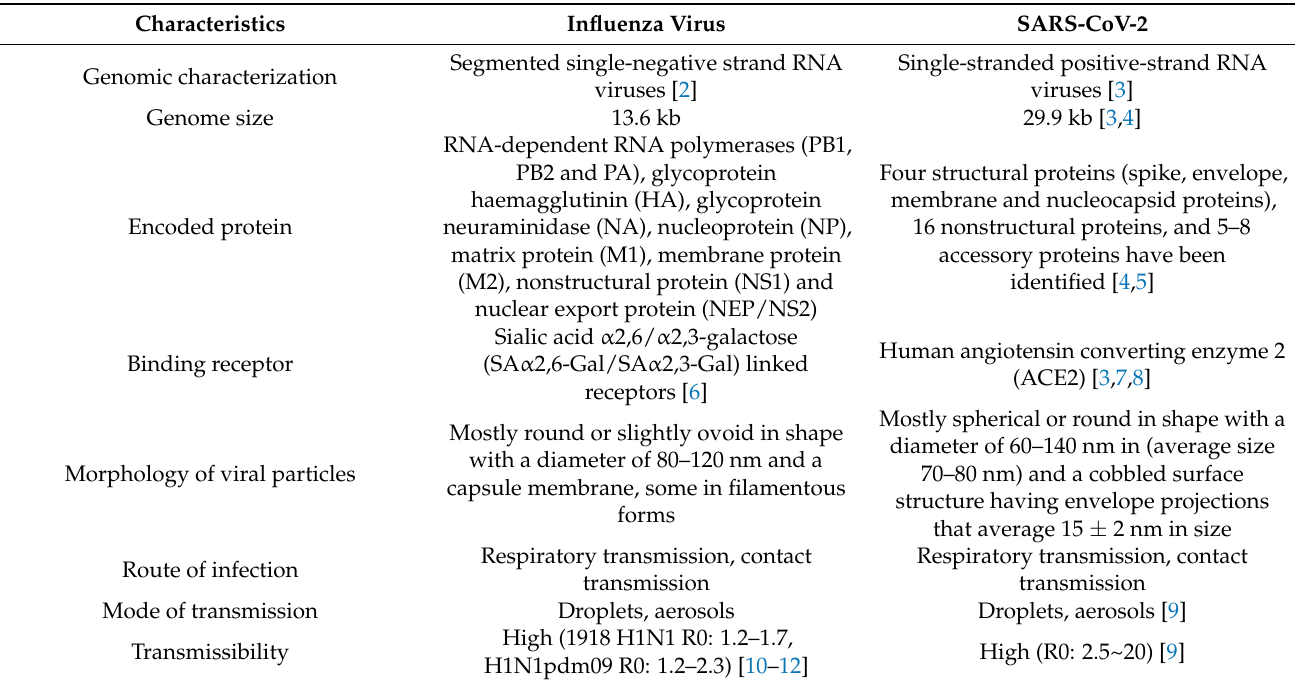
Table 1. Comparison of the basic biological characteristics of influenza virus and